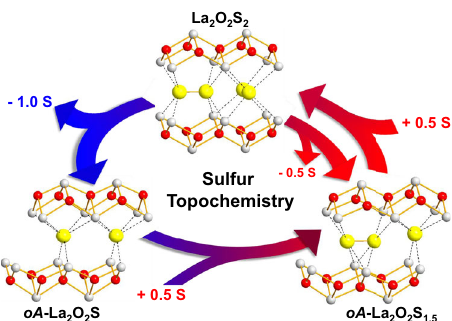
Fig. 5 Overview of the rich low-temperature sulfur topochemistry in the La – O – S system. The topochemical intercalation and deintercalation of sulfur in the oxychalcogenide compound La 2 O 2 S 2 lead to the formation of two new metastable compounds.